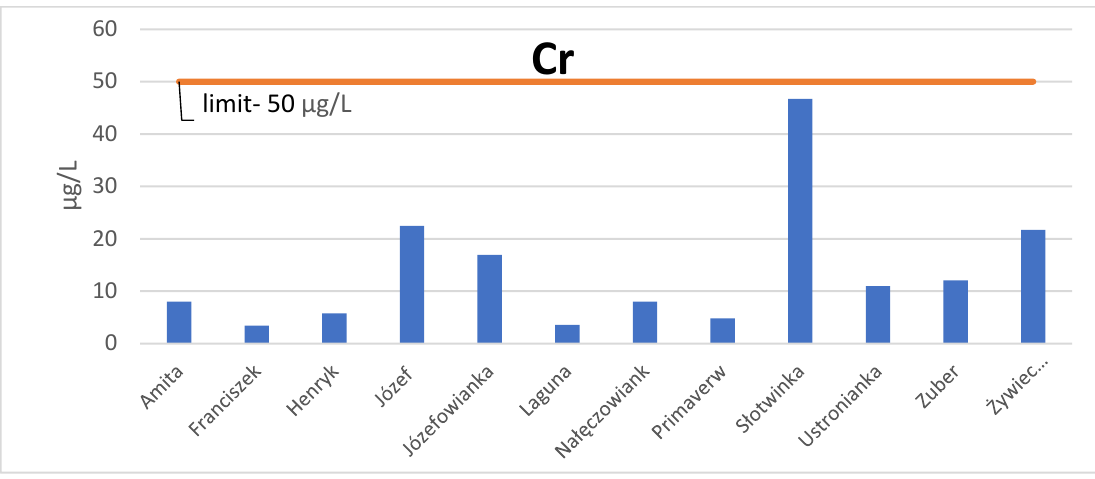
Figure 8. The concentration of cadmium in mineral waters ( μg/L ).